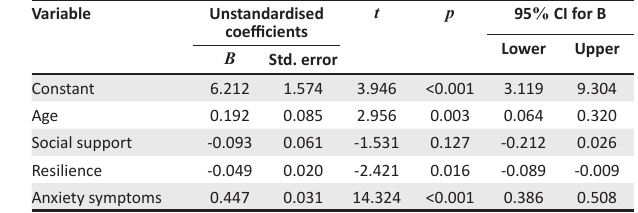
TABLE 6: Predictors of anxiety symptoms.